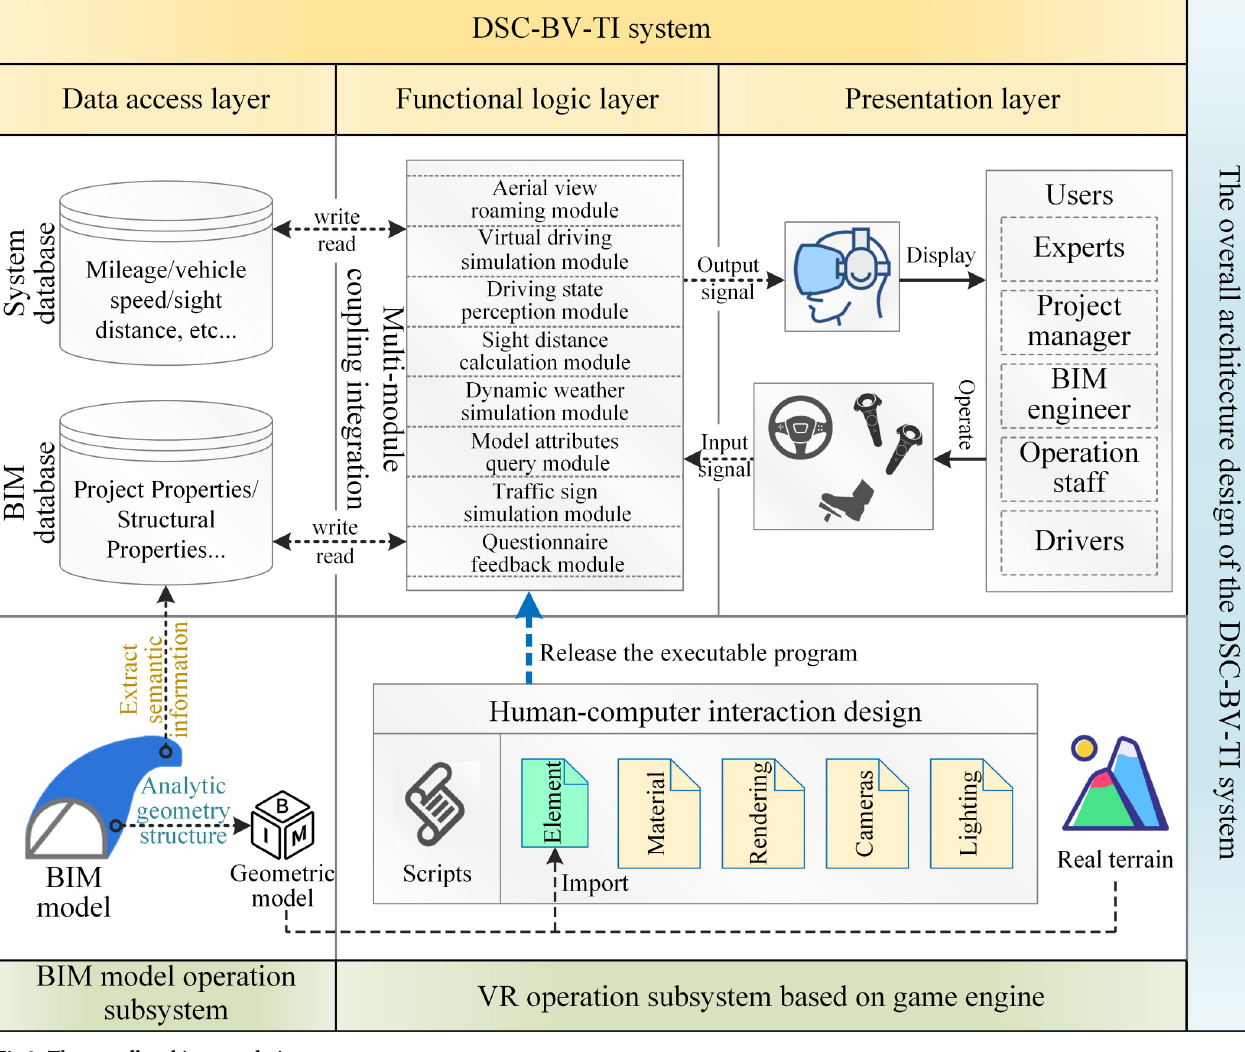
Fig 2. The overall architecture